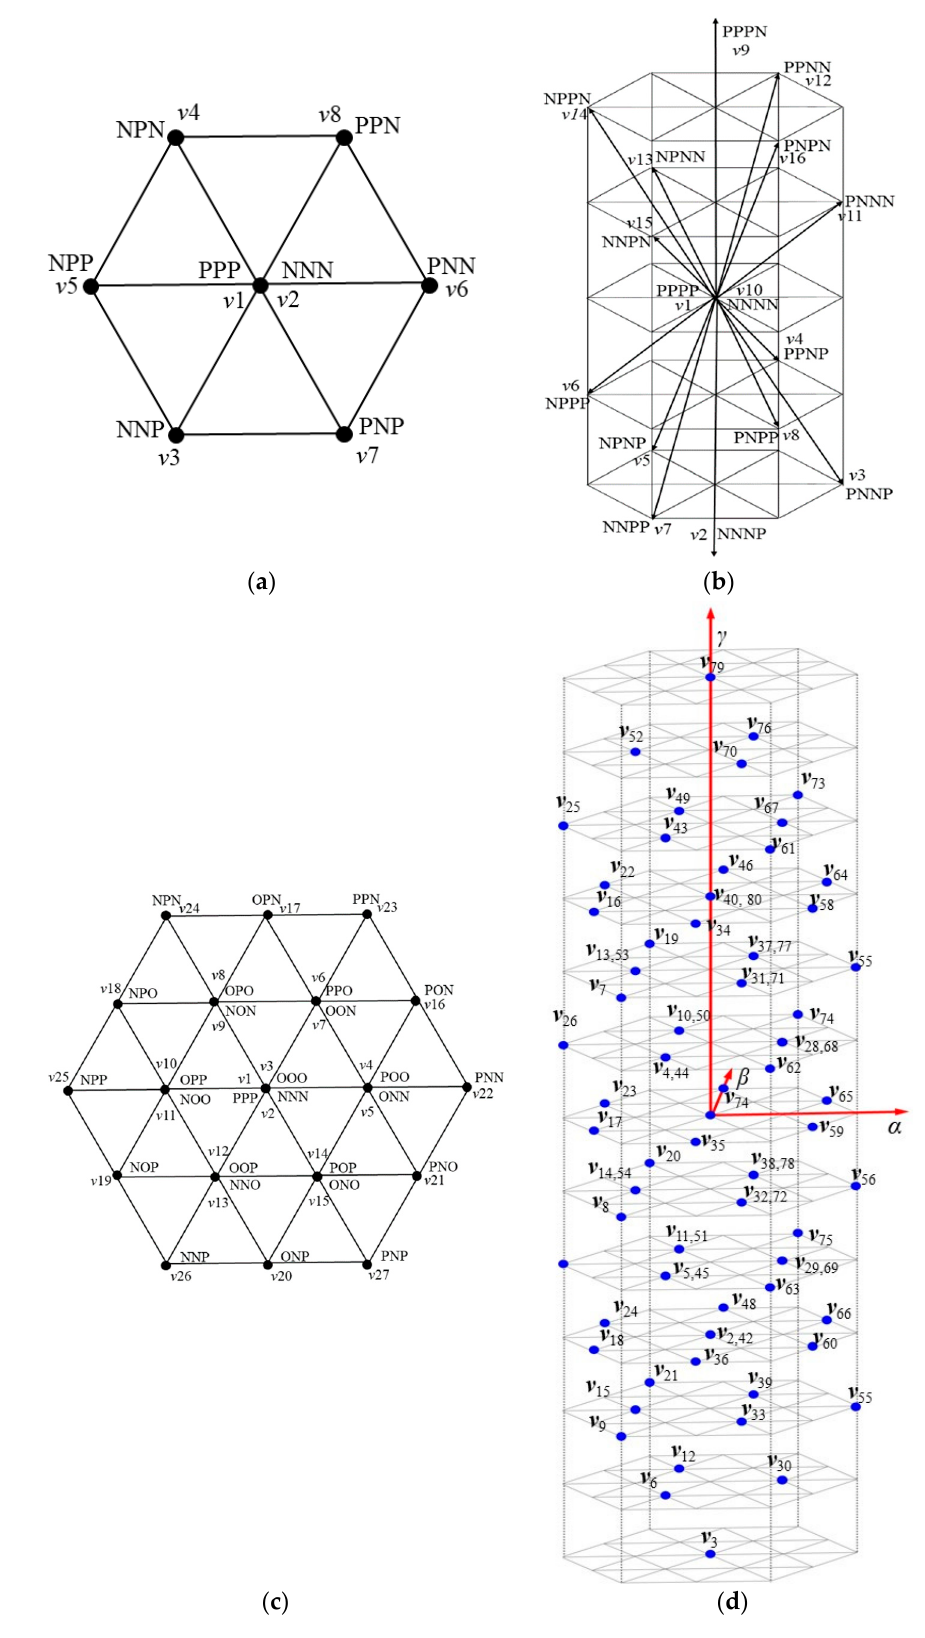
Figure 4. Voltage vector diagram of four-leg inverter: ( a ) two-level three-leg four-wire type, ( b ) two- level four-leg type, ( c ) three-level three-leg four-wire type, and ( d ) three-level type four-leg inverter.